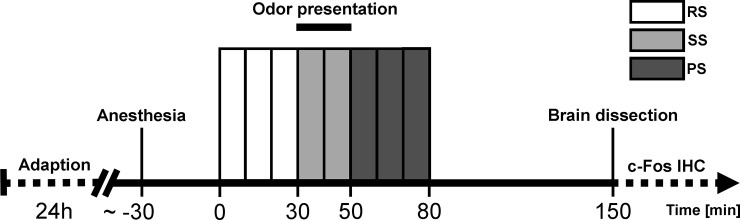
Time course of the fMRI experiment.Mice were allowed to habituate to the new environment in the adaption phase 24 h prior to the fMRI measurements. Resting state (RS, 30 min), stimulation state (SS, 20 min) and post-stimulation state (PS, 30 min) measurements comprising of separate 10 min blocks were performed on anesthetized mice. Each block consisted of 10 labeled/unlabeled MRI acquisition pairs. Two hours (120 min) after initiation of aversive or neutral odor presentation brains were dissected and processed for subsequent immunohistochemical stainings with the c-Fos antibody (c-Fos IHC).